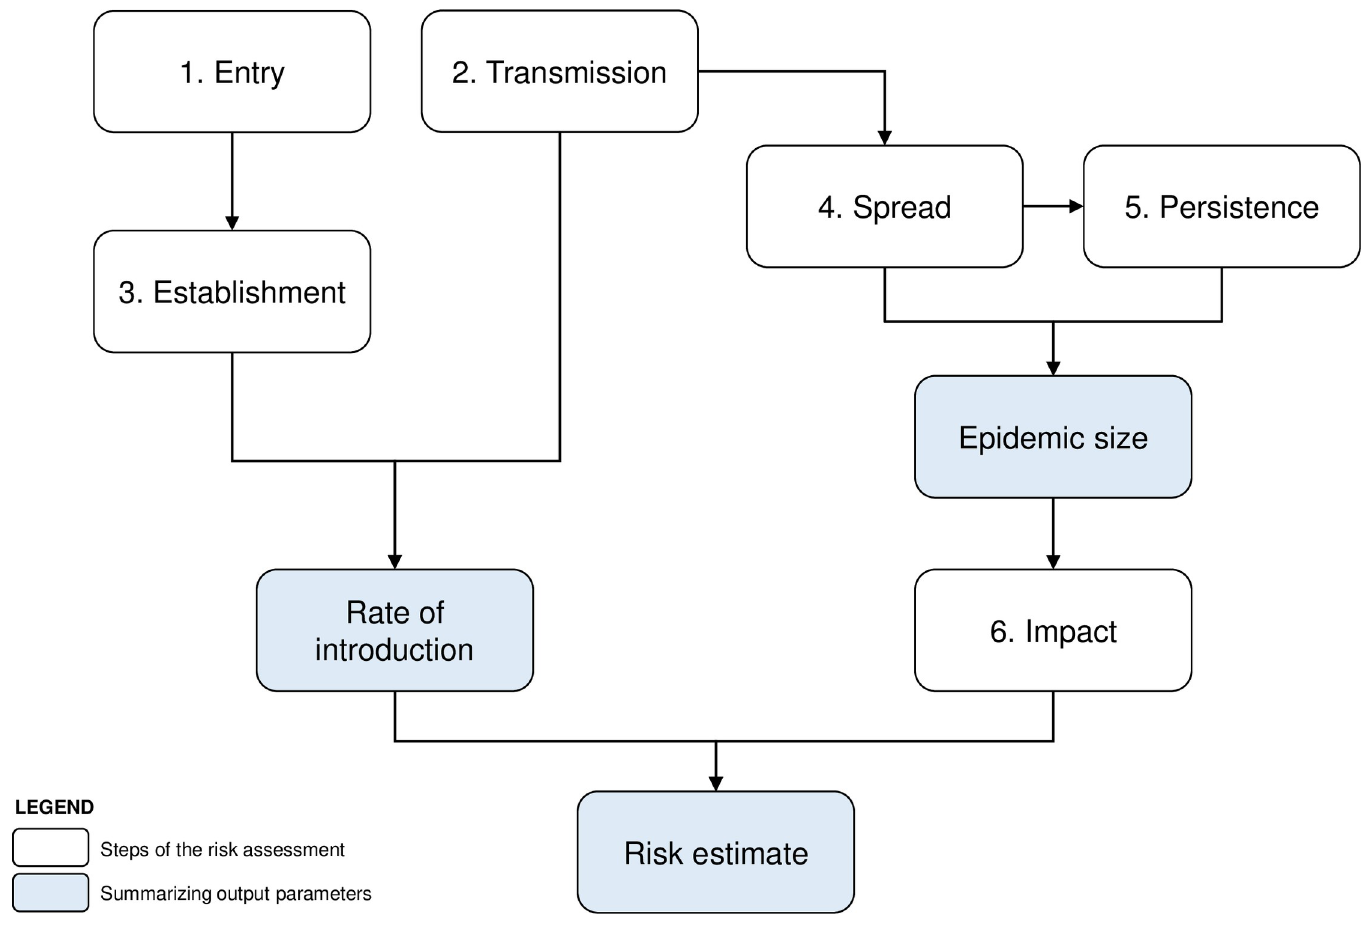
Fig 1. Outline of